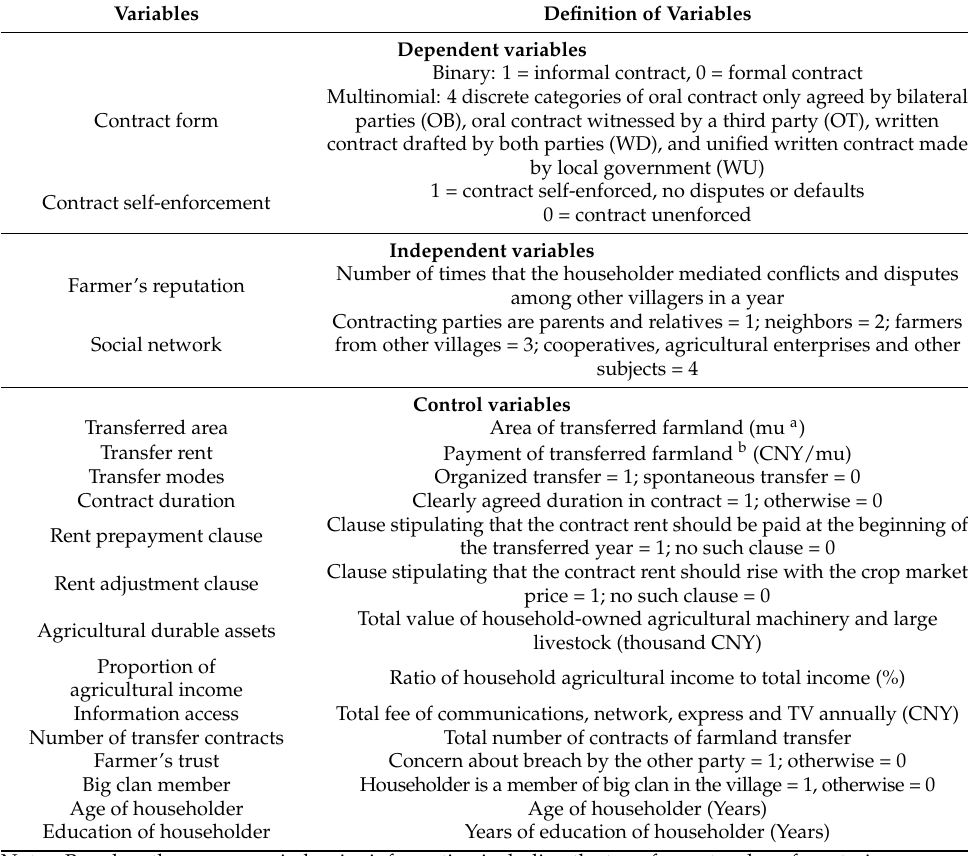
Table 2. Definition of